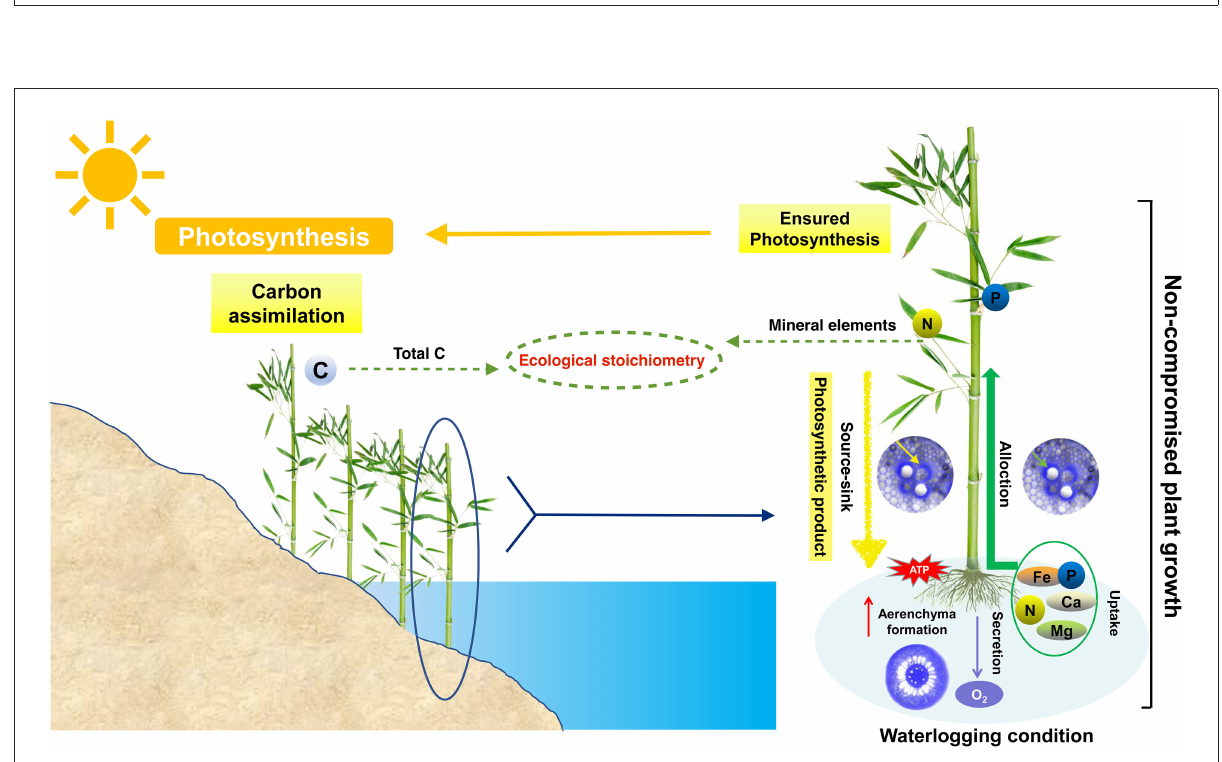
FIGURE8 Relationship between ecological stoichiometry characteristics and ecological adaptation strategies of Phyllostachys heteroclada in the riparian